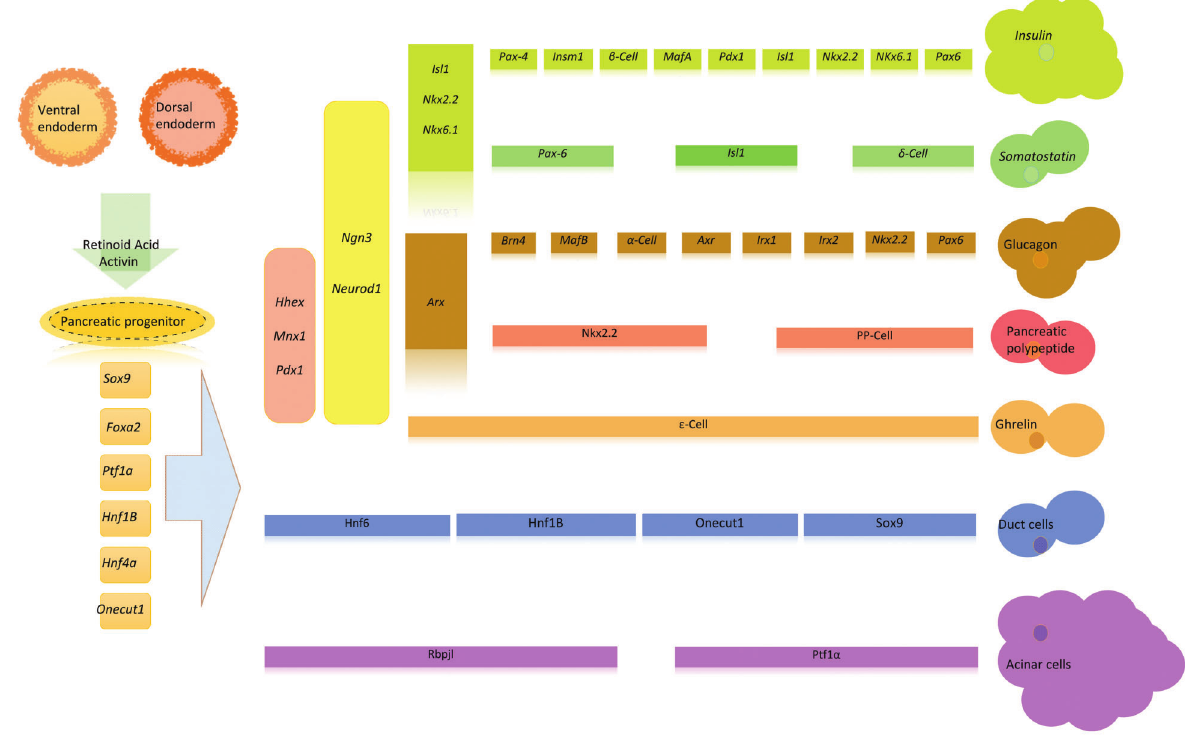
Figure 1. Schematic of pancreatic progenitors toward differentiated lineages. Upon activation of PDx1, the pancreatic fate is induced from endoderm progenitors. Pancreatic progenitors give rise to acini, ductal, and endocrine progenitors. Endocrine progenitors then differentiate into speci fi c hormone secreting cells: a , b , d , PP, and E cells. Key transcription factors involved in each differentiation step and the time they are expressed are